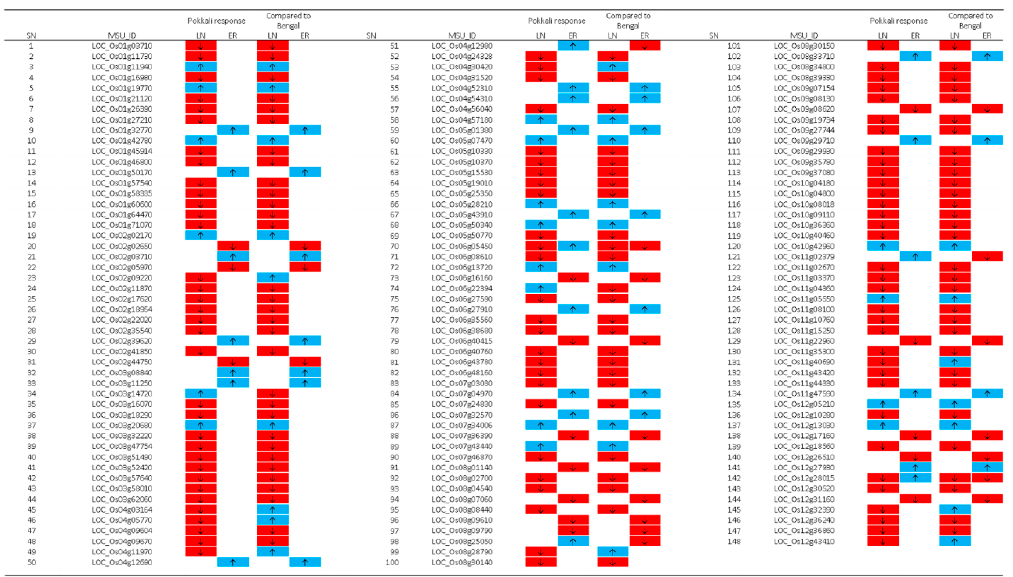
Figure 6. The 148 Pokkali-specific root DEGs under low N and early recovery conditions. The expression pattern of these genes is shown for low nitrogen (LN) and 1-h N recovery/early response (ER) in Pokkali as well as compared to Bengal. The upward arrows in blue blocks and downward arrows in red blocks indicate upregulation and downregulation, respectively.